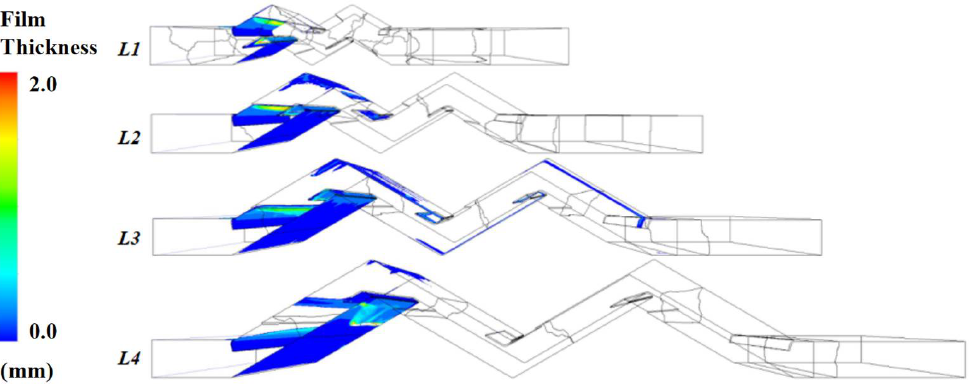
Figure 13. 3D film thickness contour under inlet velocity U g = 12.00 m/s in different wavelengths.